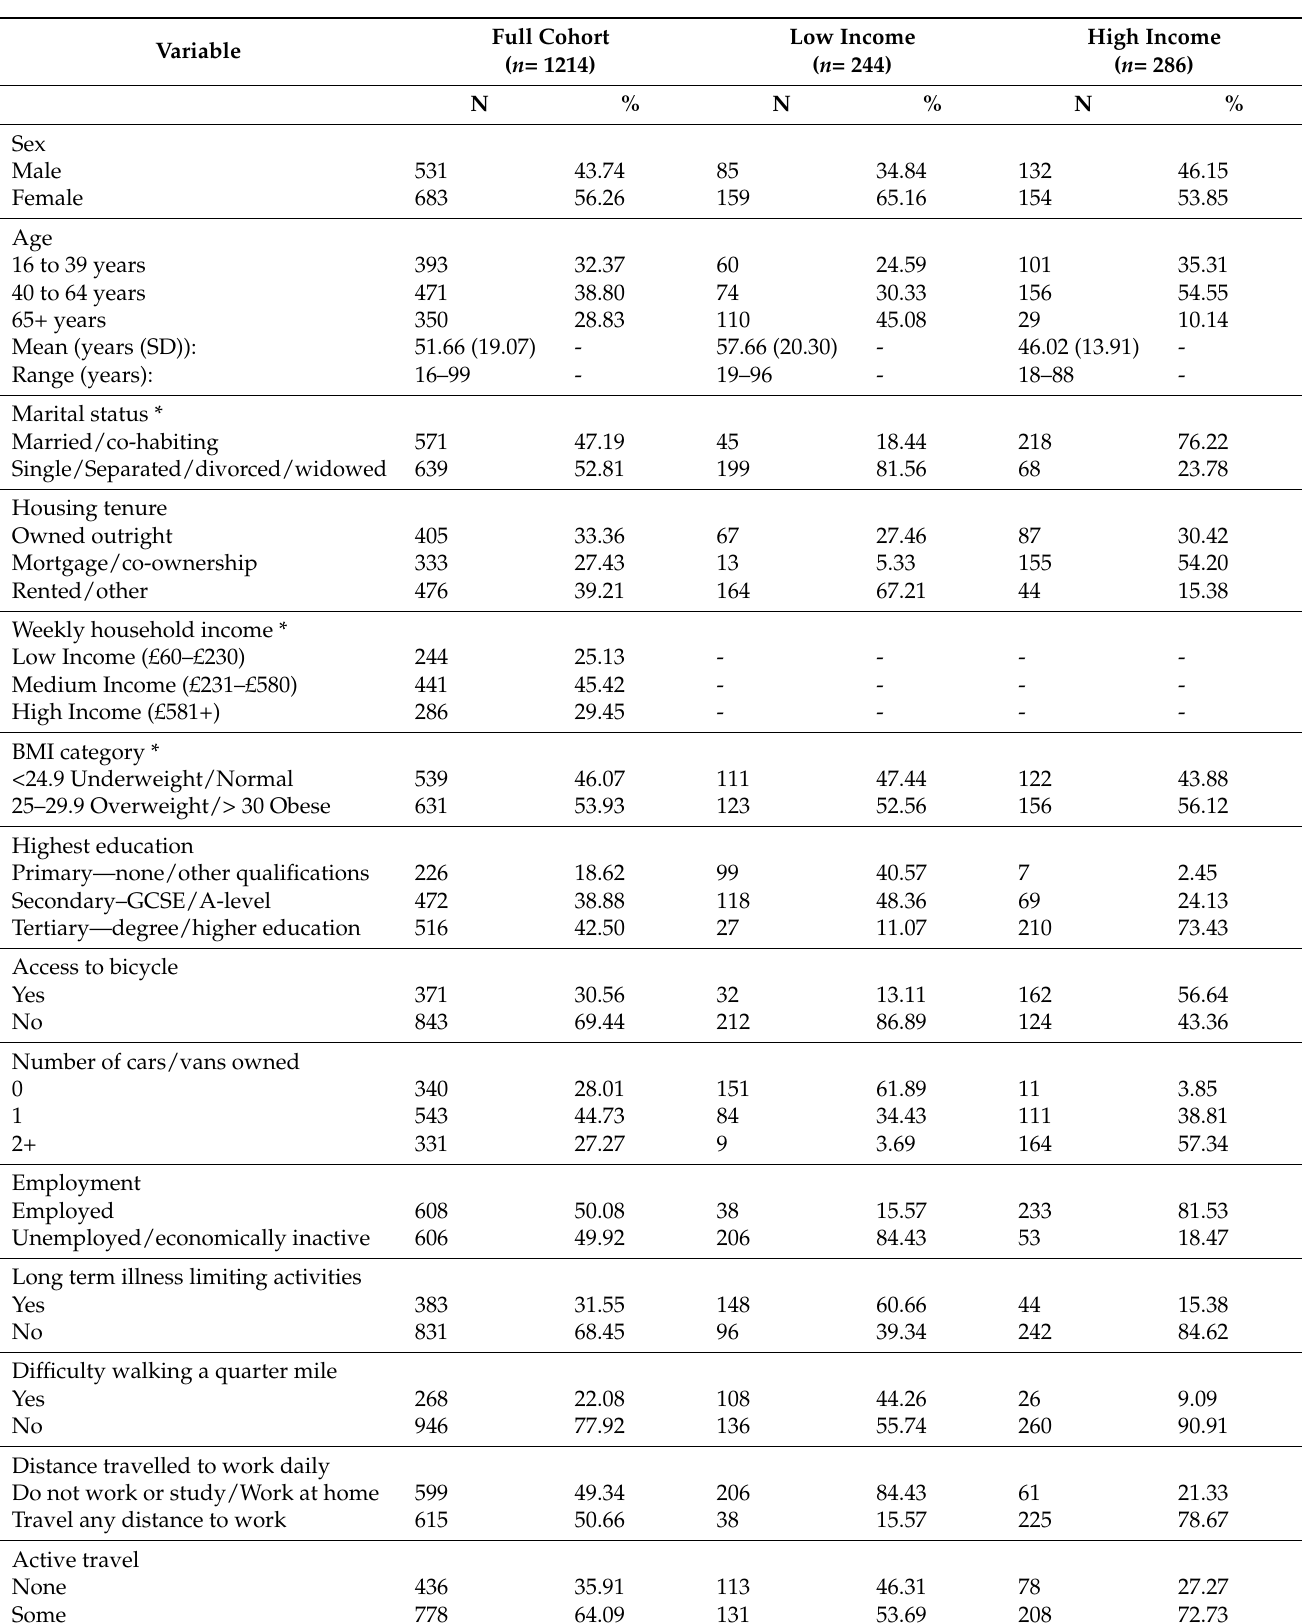
Table 1. Participant socio-demographics for full cohort and by low and high